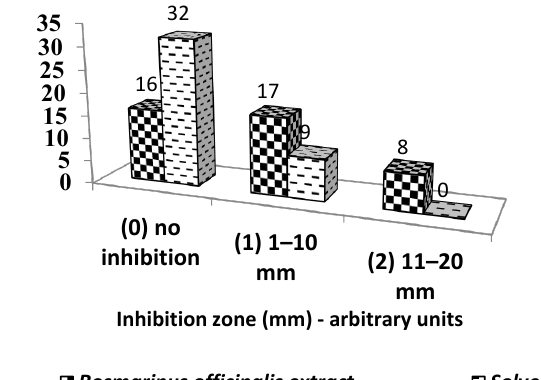
Figure 1. Graphic representation of the R. officinalis inhibition arbitrary units against fungal strains.